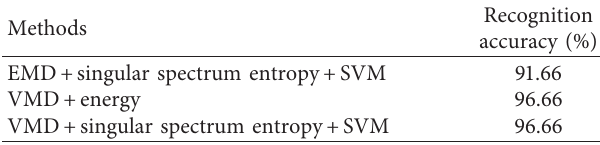
Table 4: Comparison of the three methods.